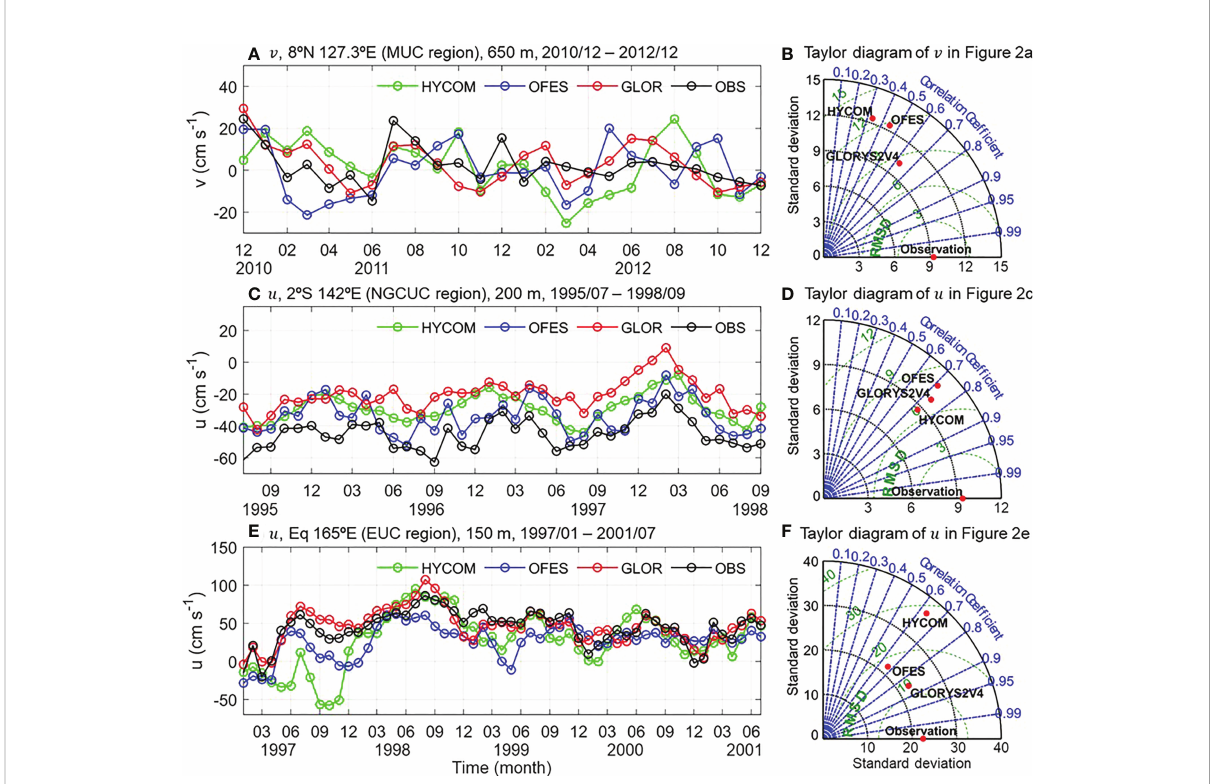
FIGURE 4 (A) Comparison of monthly meridional velocities (cm s -1 ) from mooring observation (black line) and the model outputs from GLORYS2V4 (red line), OFES (blue line), and HYCOM (green line) from December 2010 to December 2012 at approximately 8°N, 127.3°E and at the depth of approximately 650 m. (B) The Taylor diagram compares the velocities from mooring observation to the model outputs in Figure 4A. (C) and (D) are same as (A) and (B) , respectively but monthly zonal velocities (cm s -1 ) from July 1995 to September 1998 at approximately 2°S, 142°E and at the depth of approximately 200 m. (E) and (F) are same as (A) and (B) , respectively but monthly zonal velocities (cm s -1 ) from January 1997 to July 2001 at approximately Equator, 165°E and at the depth of approximately 150